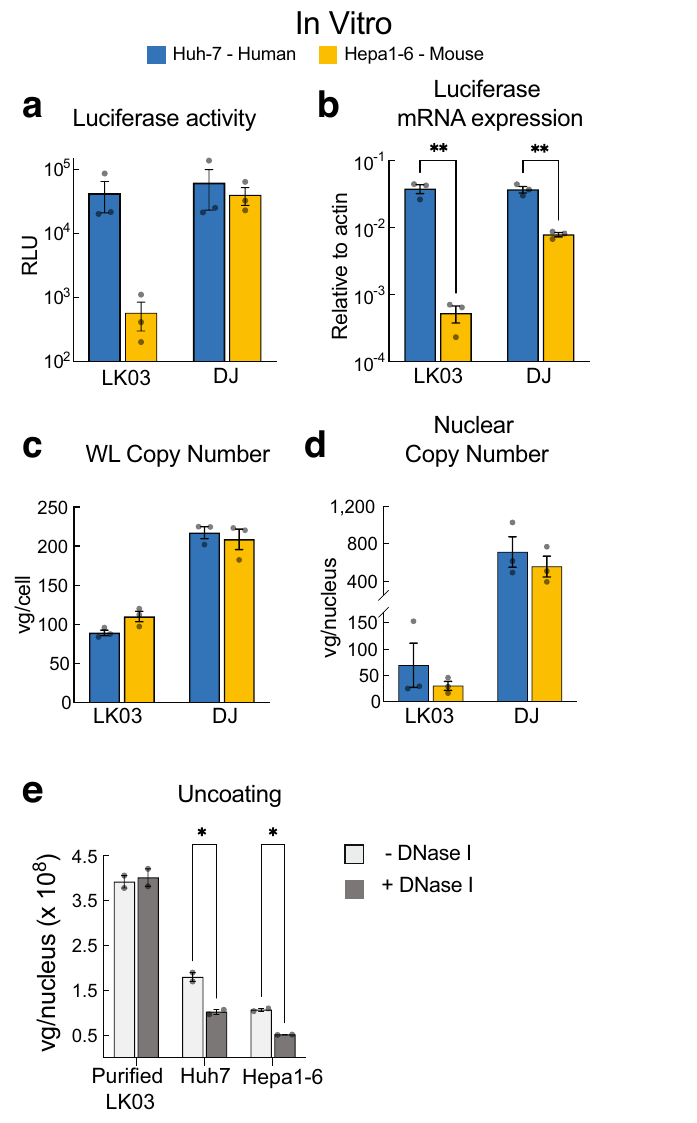
Fig. 1 | Characterization of AAV-LK03 transduction in human and mouse hepatoma cells. a – e In vitro assays using cell lines 48h post transduction, ( f – j ) in vivo assays using liver tissue 3 days post rAAV delivery (i.v. tail vein). a , f Luciferase activity quanti fi cation. b , g Relative quanti fi cation of Luciferase mRNA by qRT-PCR. c , h Quanti fi cation of vector genomes by qPCR in whole cell lysate (WL) or ( d , i ) in nuclei. e Determination of the uncoating ef fi ciency of AAV- LK03 by quanti fi cation of vector copies in DNase I treated vs untreated nuclear extracts. j Southernblotanalysisinlivertissueprobingfortheluciferasegene.The